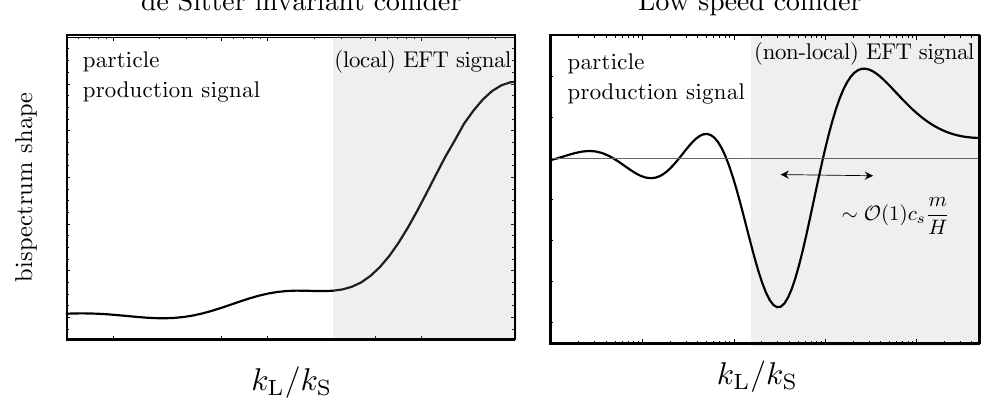
Figure 2 . In de Sitter invariant and more generally equal speed setups (left schematic plot), heavy particles induce a non-Gaussian signal that around equilateral configurations (i.e. k 1 ) can L /k S ∼ be captured by a local EFT description, while they leave characteristic oscillatory imprints in the squeezed limit of the bispectrum (i.e. k 1 ). In the low speed collider signal (right plot), a L /k S (cid:28) supersonic particle lighter than H/c manifests itself as a resonance in the extended equilateral s configurations (defined by O (1) c . k 6 1 , while the associated particle production effect m s L /k S H dominates the signal in the ultra-squeezed limit (i.e. k 2 c ). Unless the mass is close to the L /k S (cid:28) s Hubble scale, the resonance signal can be reproduced by adding an enough number of non-local EFT operators of the type discussed in section